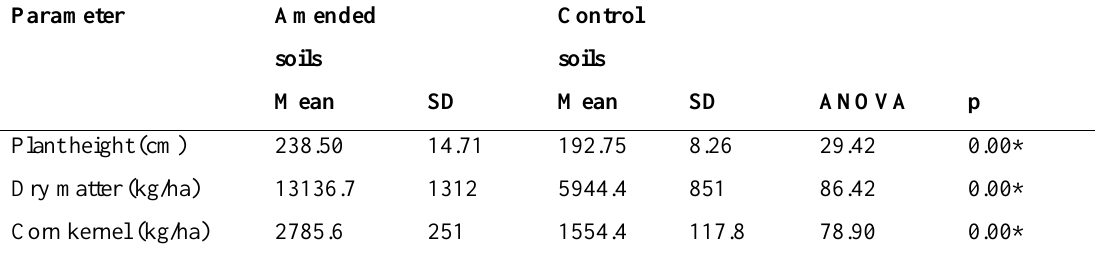
Table 4 Mean values of corn yield,*